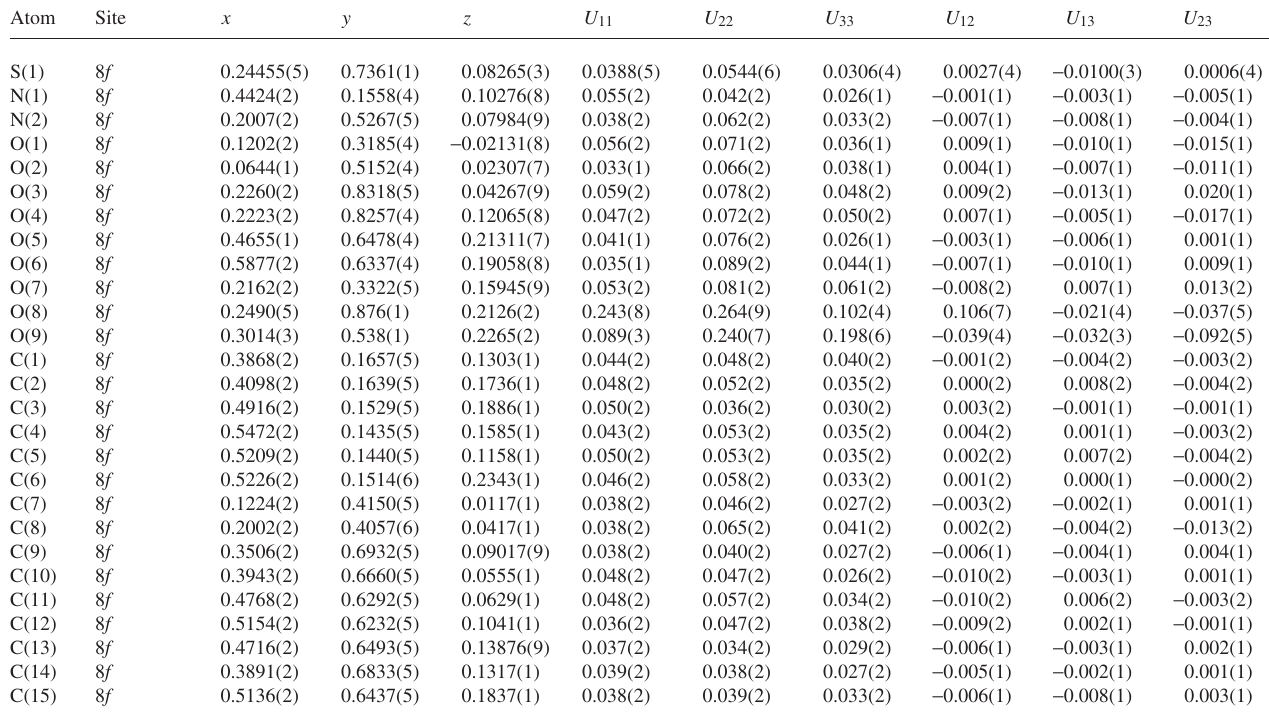
Table 3. Atomic coordinates and displacement parameters (in Å 2 ) .